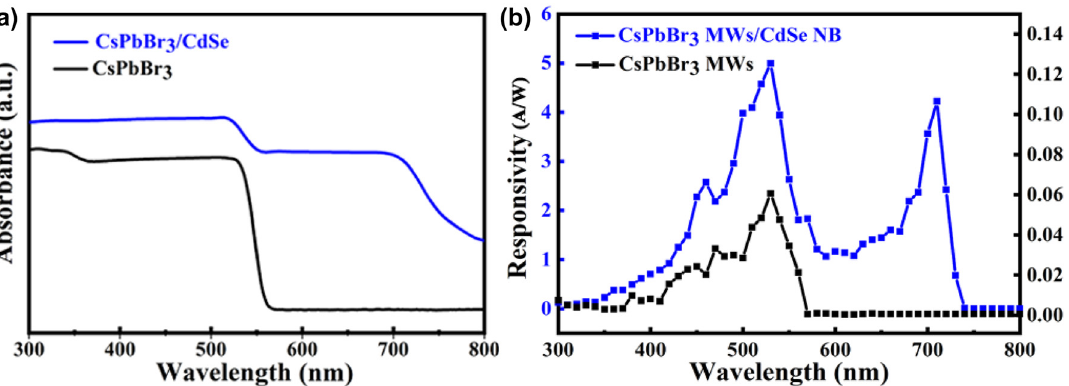
Figure 4: The spectral response of CdSe NB/CsPbBr MWs and CsPbBr MW/CdSe NB hybrid structure, 3